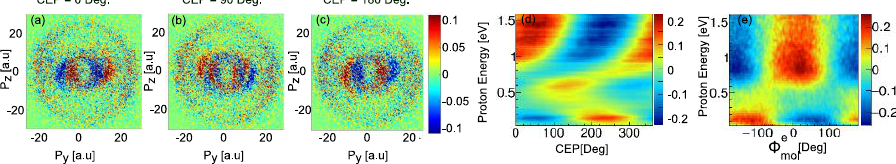
Fig. 1. (a)-(c) 2D asymmetry patterns of proton yield in the polarization plane for three different values of the CEP. (d) CEP dependent asymmetry observed in the lab frame as a function of proton energy. (e) Asymmetry in proton ejection as a function of the electron emission angle ( 𝜙 𝑚𝑜𝑙𝑒